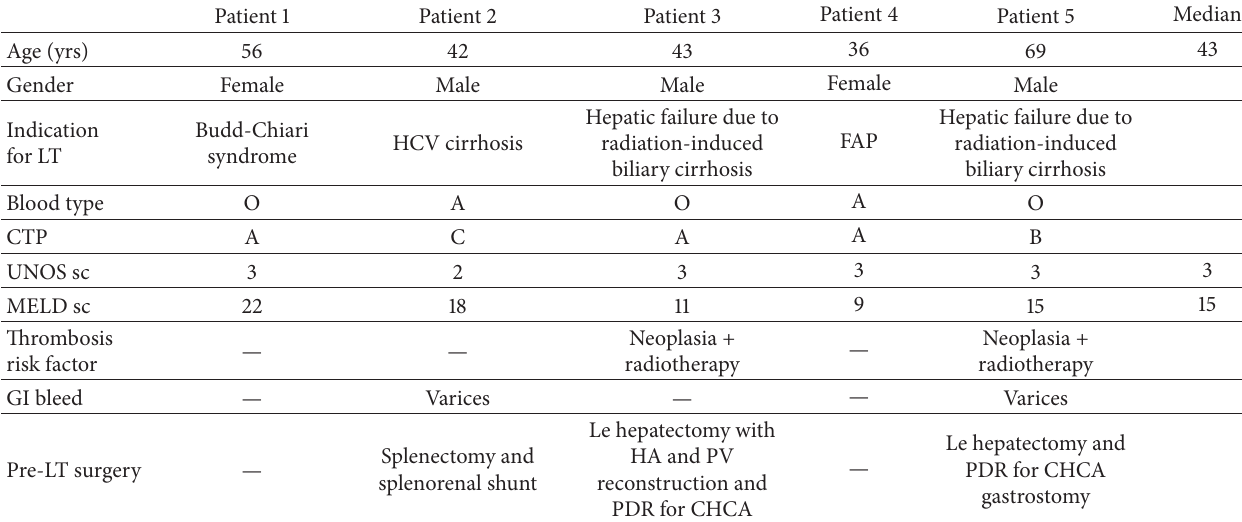
Table 1: Recipient pretransplant